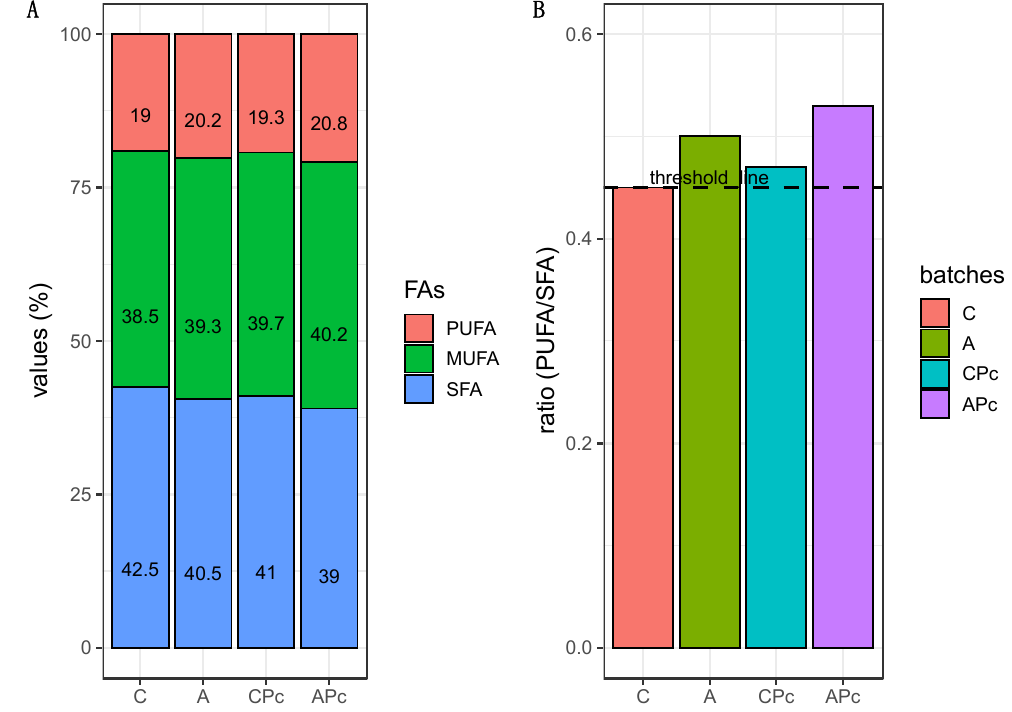
Figure 6. Stacked bar plot ( A ) showing the distribution of fatty acids (PUFA, MUFA, SFA) and bar plot ( B ) showing the ratio PUFA / SFA in samples from batch C, conventional fermented sausage prepared with starter culture and 14% minced pork fat additions; batch A, prepared with 4% lemon albedo in total replacement of pork fat and starter culture addition; batch CPc, prepared with starter culture and 14% minced pork addition plus anti- Listeria Lactiplantibacillus plantarum Lpls100; batch APc, prepared with 4% lemon albedo in total replacement of pork fat and starter culture addition plus anti- Listeria Lactiplantibacillus plantarum Lpls100. The dashed line represents the threshold value 0.45.